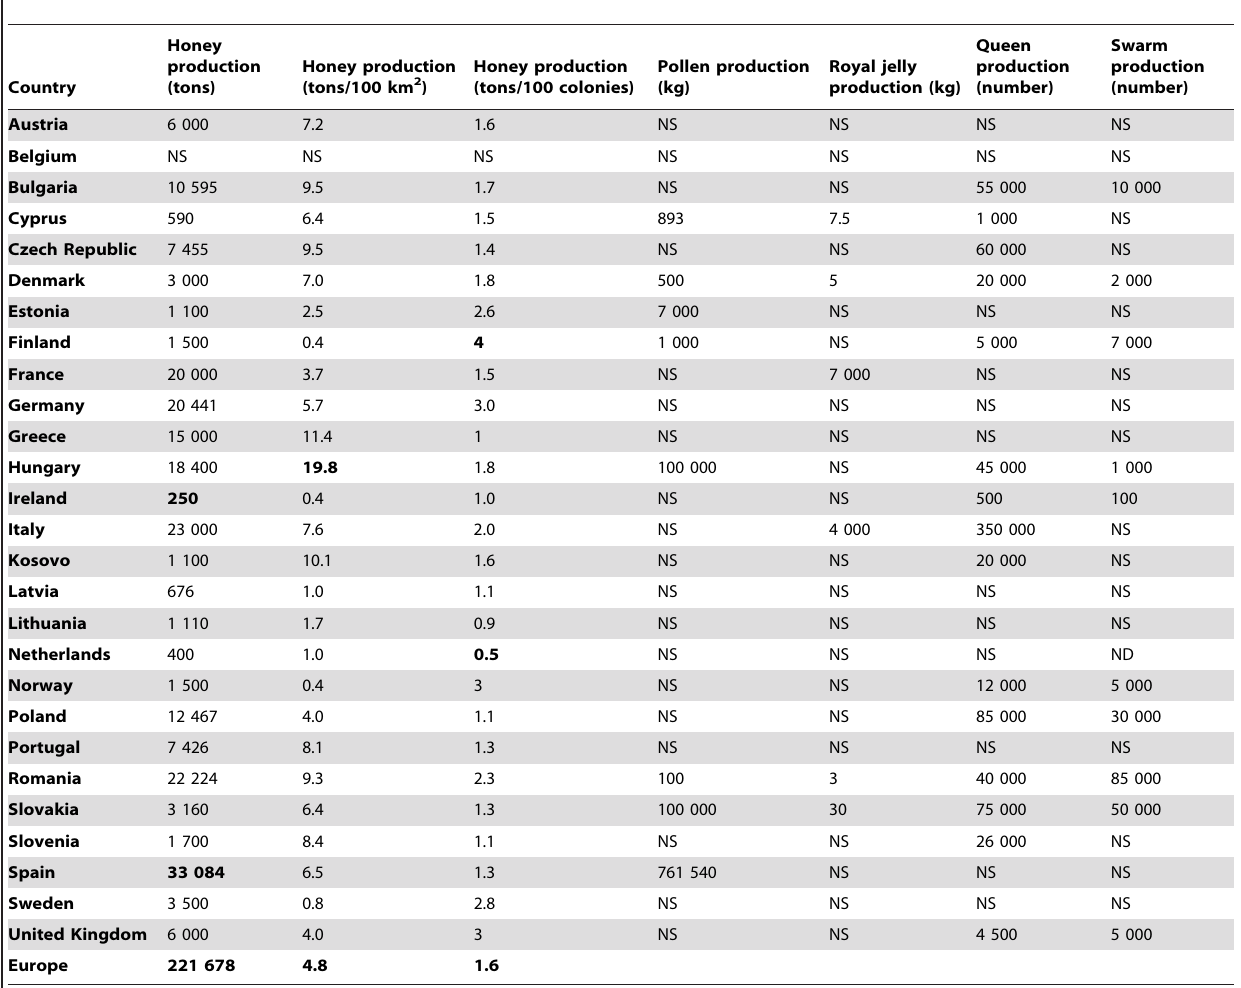
Table 4. European production of bee products in